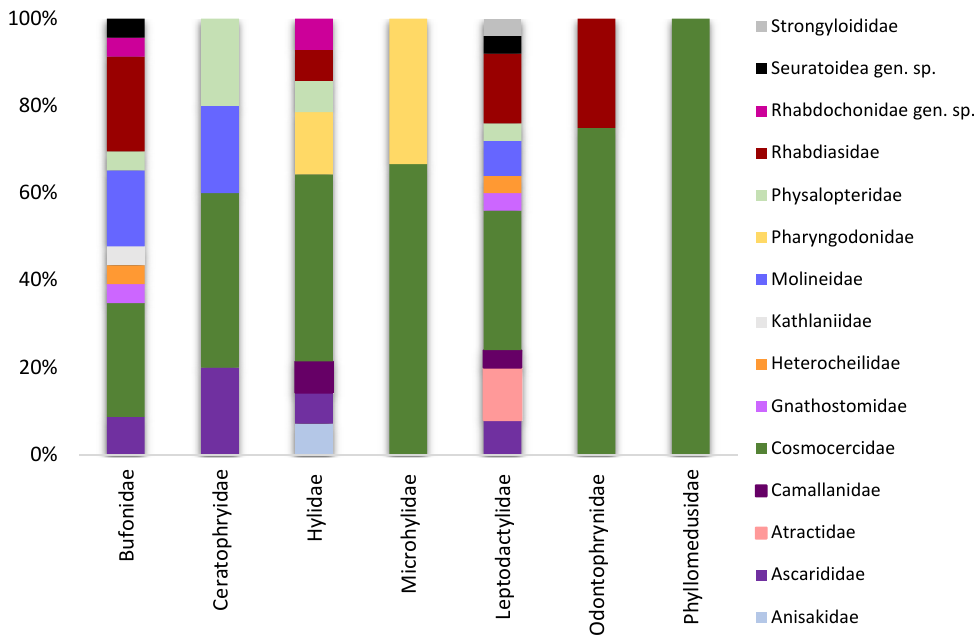
Figure 3. Composition of nematode family in percentage, in each amphibian family analyzed from Dry and Humid Chaco.